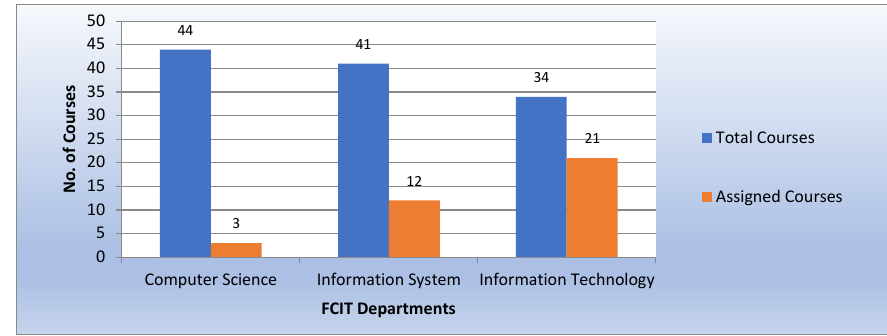
Figure 13. Assigned courses from the previous study [2].